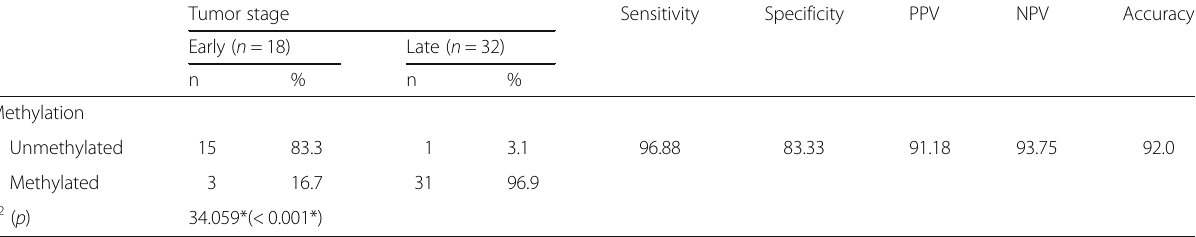
Table 2 Diagnostic performance of methylation to differentiate early and late tumor stages Tumor stage